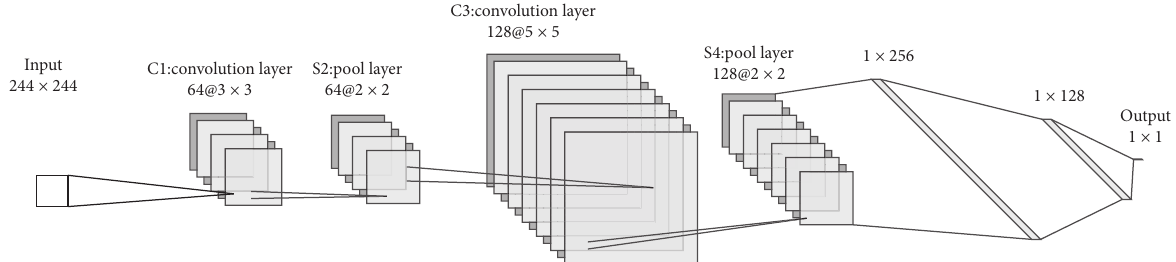
Figure 2: The layers of the proposed convolutional neural networks. Table 1: All the testing accuracy of different CWTs and segments to predict classification of blood pressure.